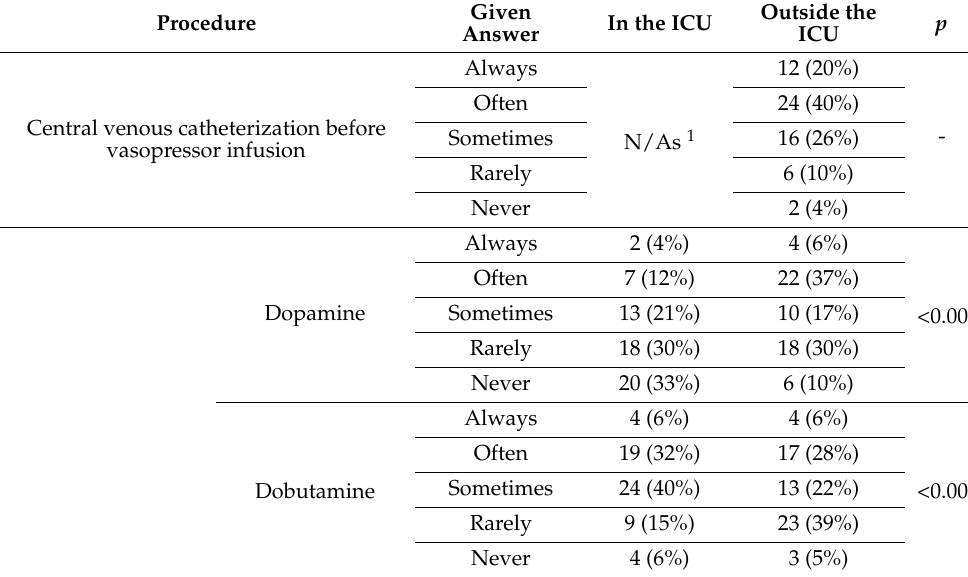
Table 4. Hemodynamic management in sepsis and septic shock—use of catecholamines and vaso- pressors in septic shock